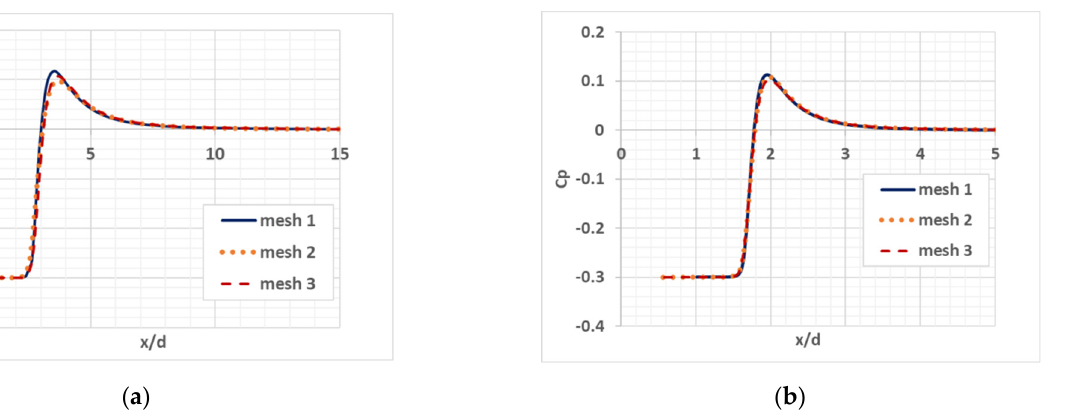
Figure 2. The pressure coe ffi cient distribution over the cylinder length: ( a ) A cylinder with a plane end; ( b ) A cylinder with a semispherical end. end; ( b ) A cylinder with a semispherical